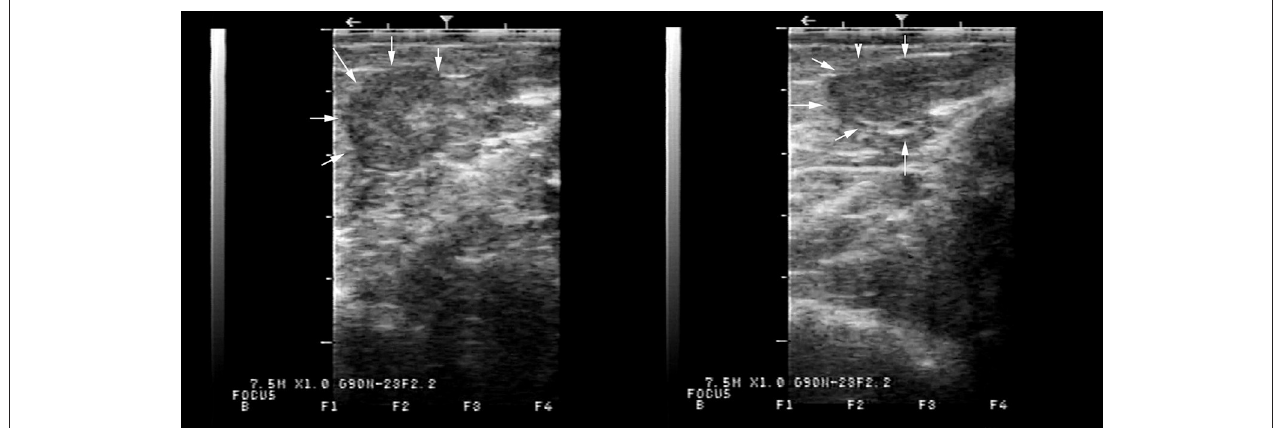
FIGURE 1 | Typical appearance of the underdeveloped flaccid uterus on transrectal ultrasonography of two alpacas presenting with lack of ovarian activity. The uterus, delineated by arrows, measured in diameter, 6.5mm in one case and 7.8mm in the other.